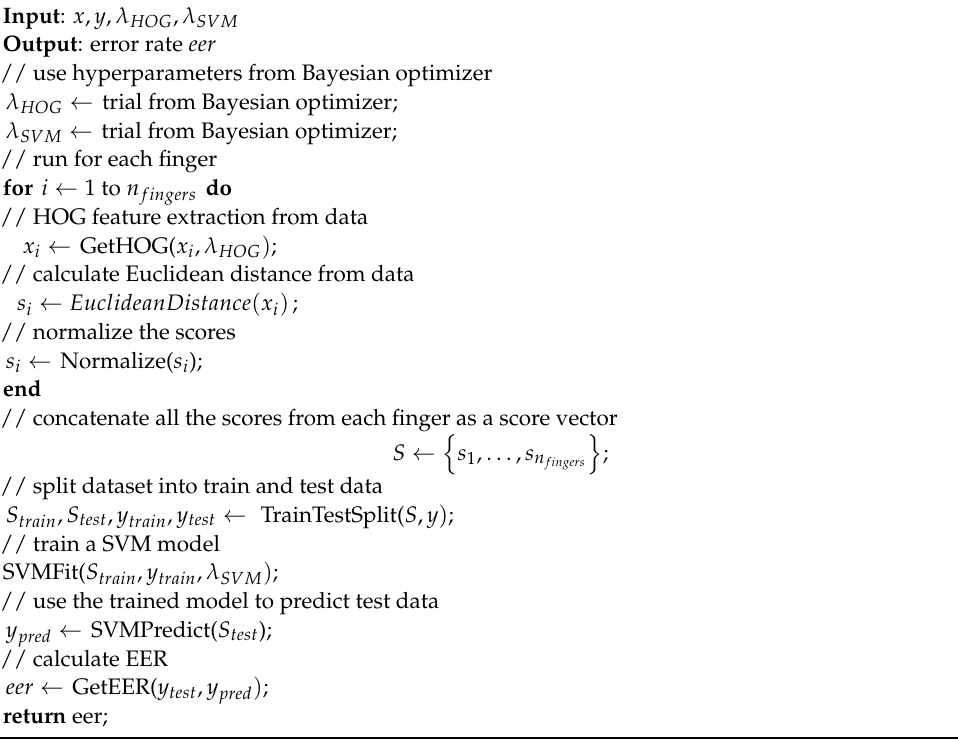
Algorithm 3 BSBF Objective Function